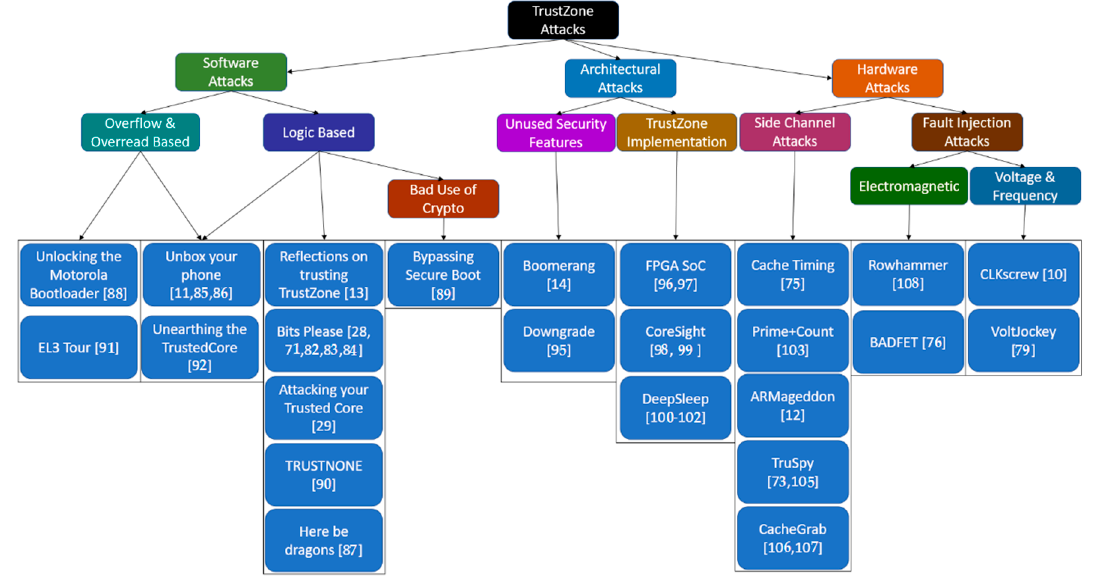
Figure 5. TrustZone Attack Taxonomy.